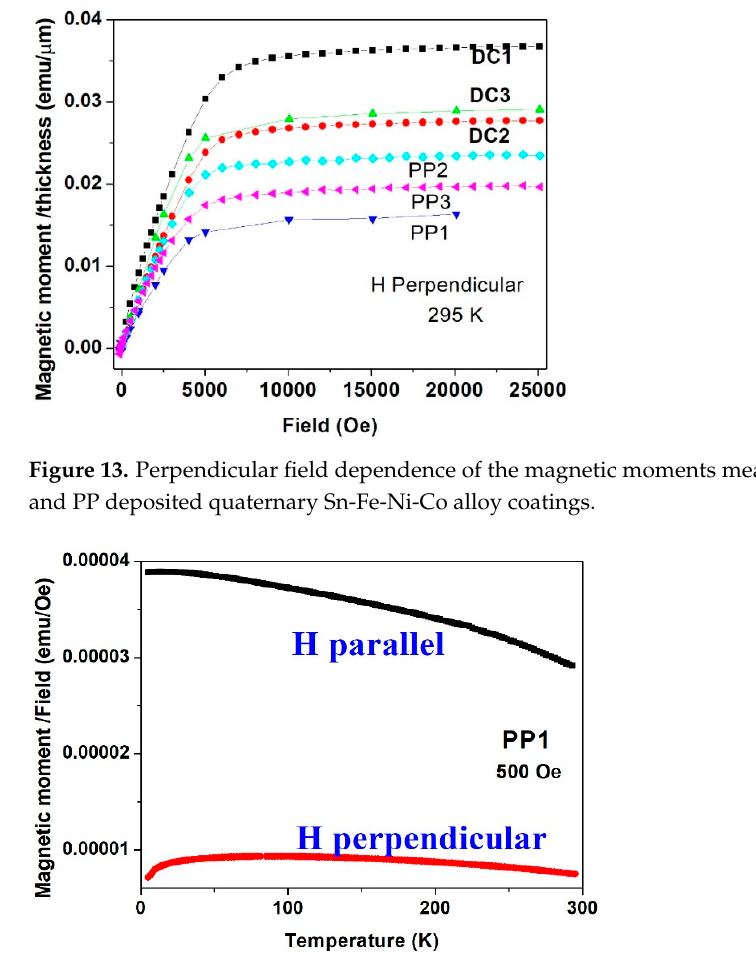
Figure 14. The temperature dependence of the susceptibility ( m / H ) under applied fields of 500 Oe measured parallel and perpendicular of PP1 sample.